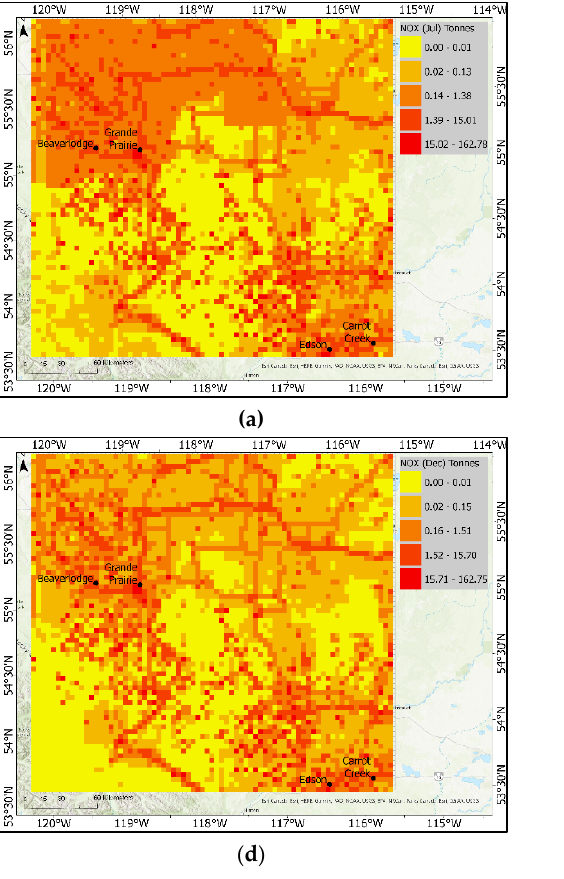
Figure 2. 2013 Spatial distribution of NOx, VOC, and PM 2.5 emissions in July (top) and December (bottom) in the modelling domain. ( a ) NO X (summer), ( b ) VOC (summer), ( c ) PM 2 . 5 (summer), ( d ) NO X (winter), ( e ) VOC (winter), ( f ) PM 2 . 5 (winter).